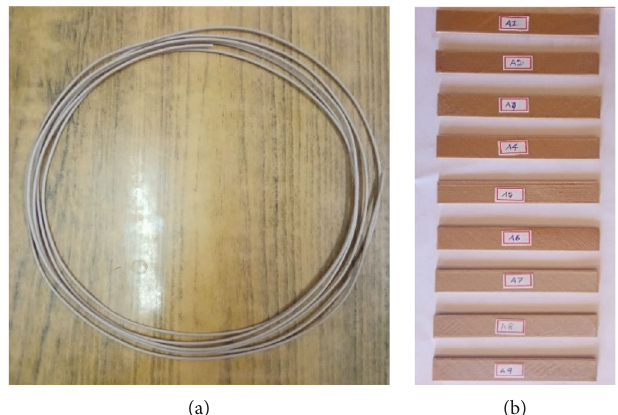
Figure 2: (a) Filament of PLA/25% ACF extrudate of diameter 1.75mm, and (b) FDM-fabricated PLA/25wt% ACF composite